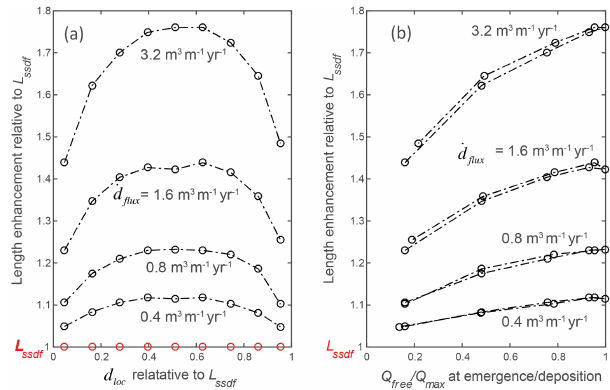
Figure 7. Glacier length variations with changes in debris flux( ˙ d flux ) and debris deposition location( d loc ). Modeled glacier length is normalized by the steady state debris free glacier length ( L ssdf ). Each string of connected markers represents simulations with the same debris flux ( ˙ d flux ). Changes in ˙ d flux are accomplished by changing ˙ d with d width held constant. The red markers indicate the ssdf glacier length. (a) Normalized glacier length relative to d loc . (b) Normalized glacier length relative to Q free /Q max at the point of debris emergence/deposition.